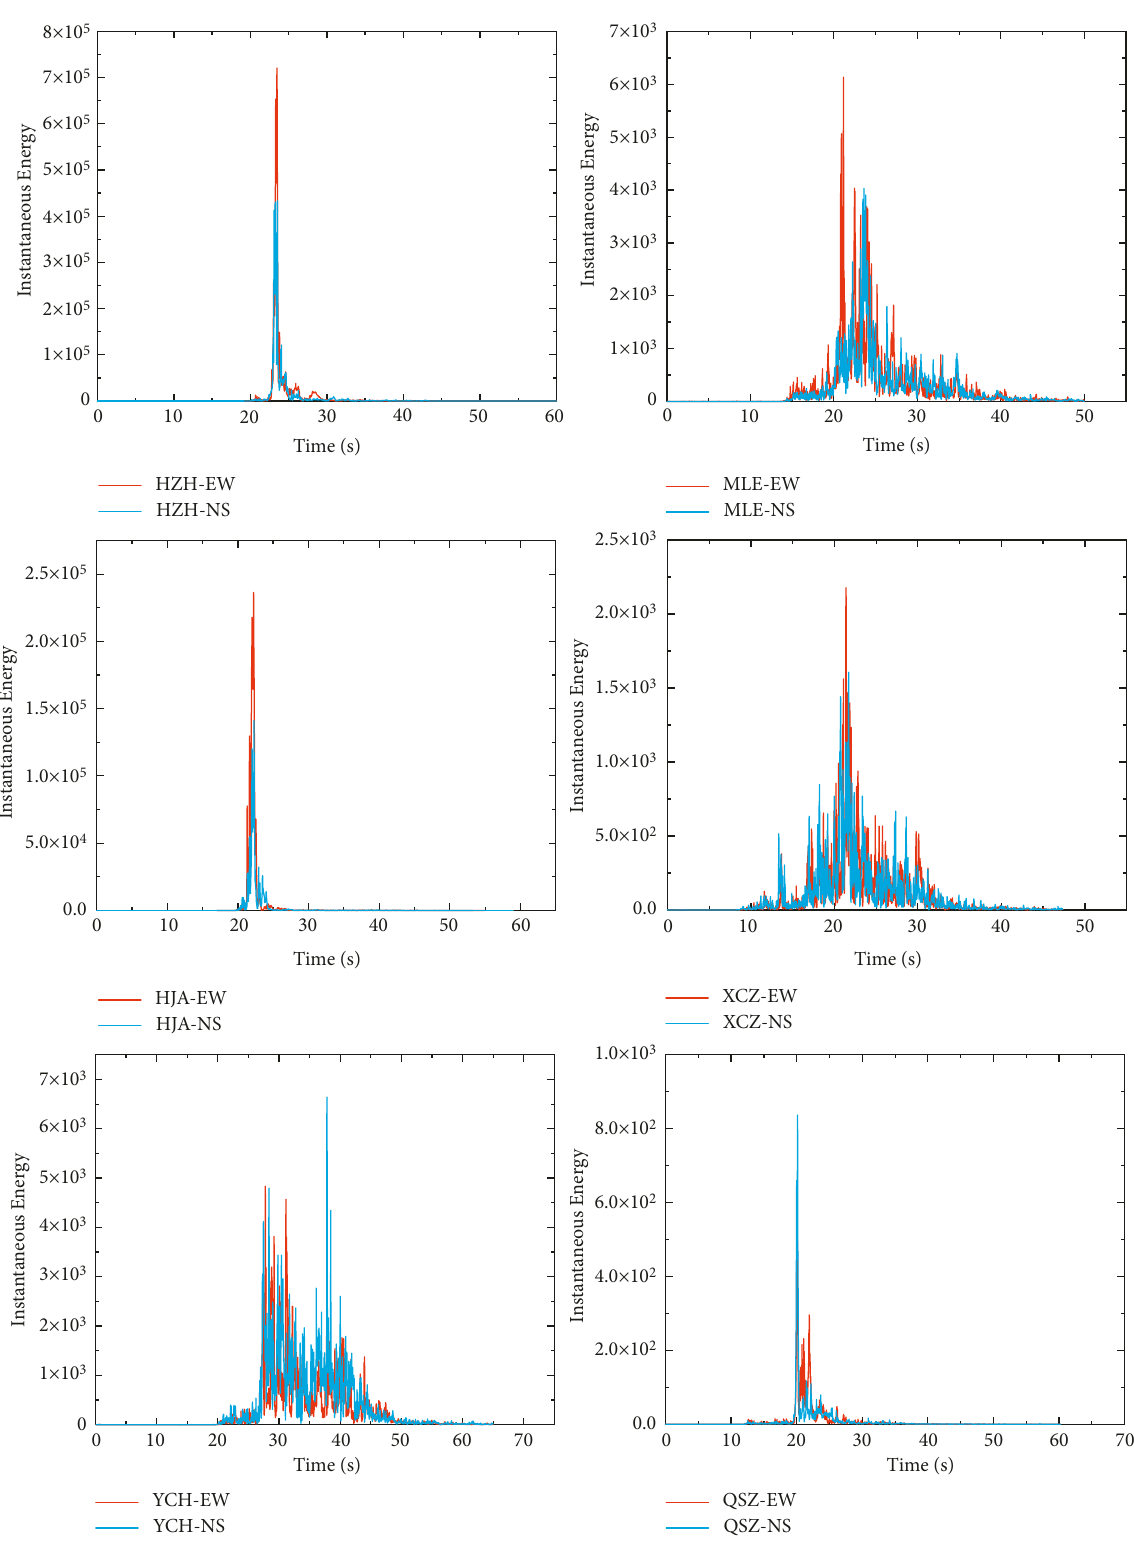
Figure 7: Instantaneous energy spectrum of each strong motion